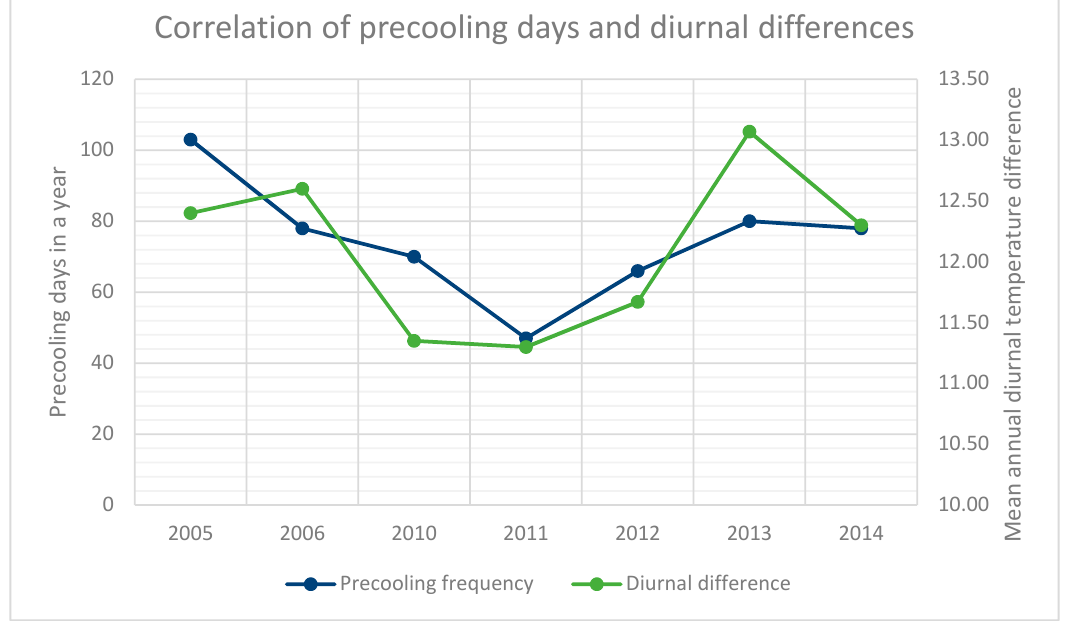
Figure 9. Comparison of precooling days per year and the magnitude of the mean annual diurnal temperature difference.